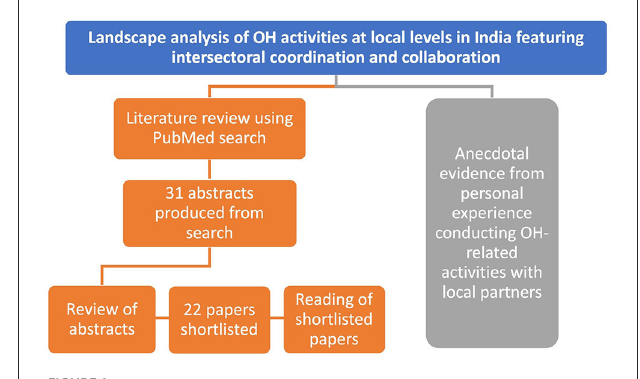
FIGURE1 Overview of landscape analysis approach to evaluate OH activities at local levels in India featuring intersectoral coordination and collaboration. A literature review using PubMed search produced 31 abstracts based on search terms. These abstracts were reviewed, and 22 of them were shortlisted for in-depth reading and evaluation of these publications by co-authors. In parallel, examples of local intersectoral coordination and collaboration on OH activities were identified through personal experience conducting and knowledge of relevant activities with local